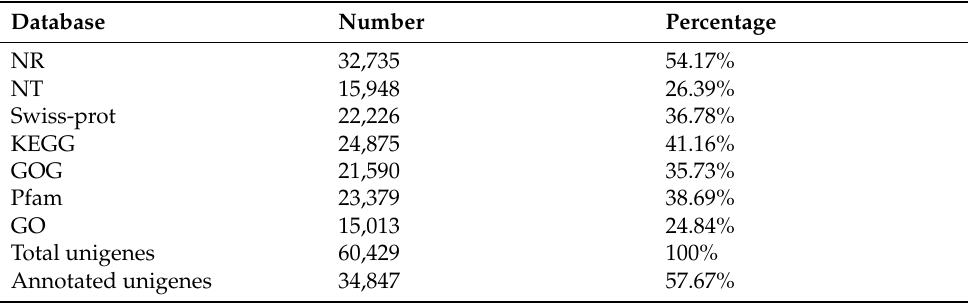
Table 3. Summary of the annotations of the assembled C. sacchariphagus